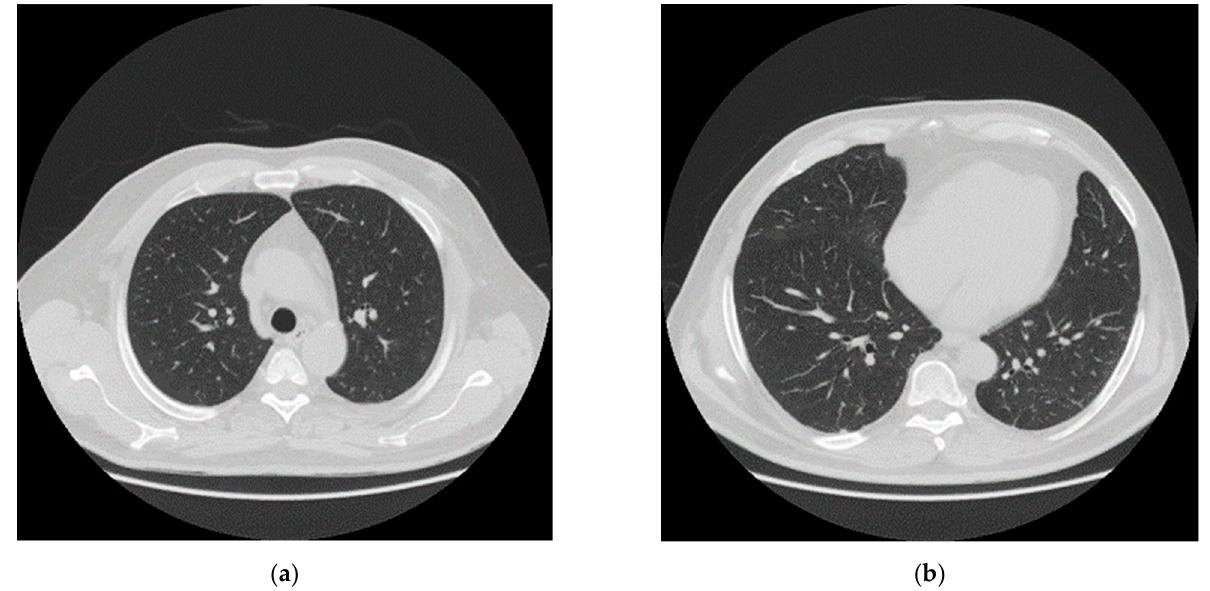
Figure 3. CT after one month of intensive care and one month of sub intensive care. ( a , b ) Axial nonenhanced chest CT images (lung window) show almost complete absorbent of lesions.